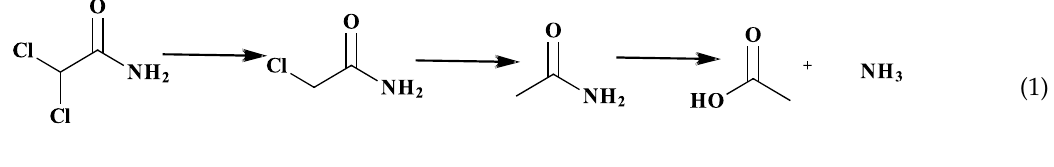
Table 4. The medium e ff ect on dehalogenation yields of DAcAm and MAcAm *.